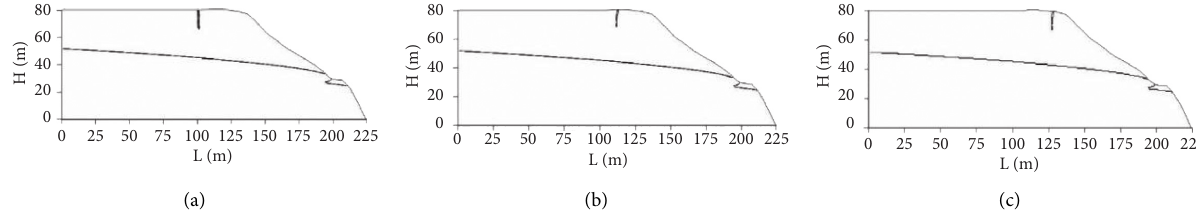
Figure 14: Distribution curve of matric suction (kPa) in the slope at different fissure locations. (a), (b), and (c) The distance between the fracture location and the edge of the pier is 33m, 15m, and 5 m.